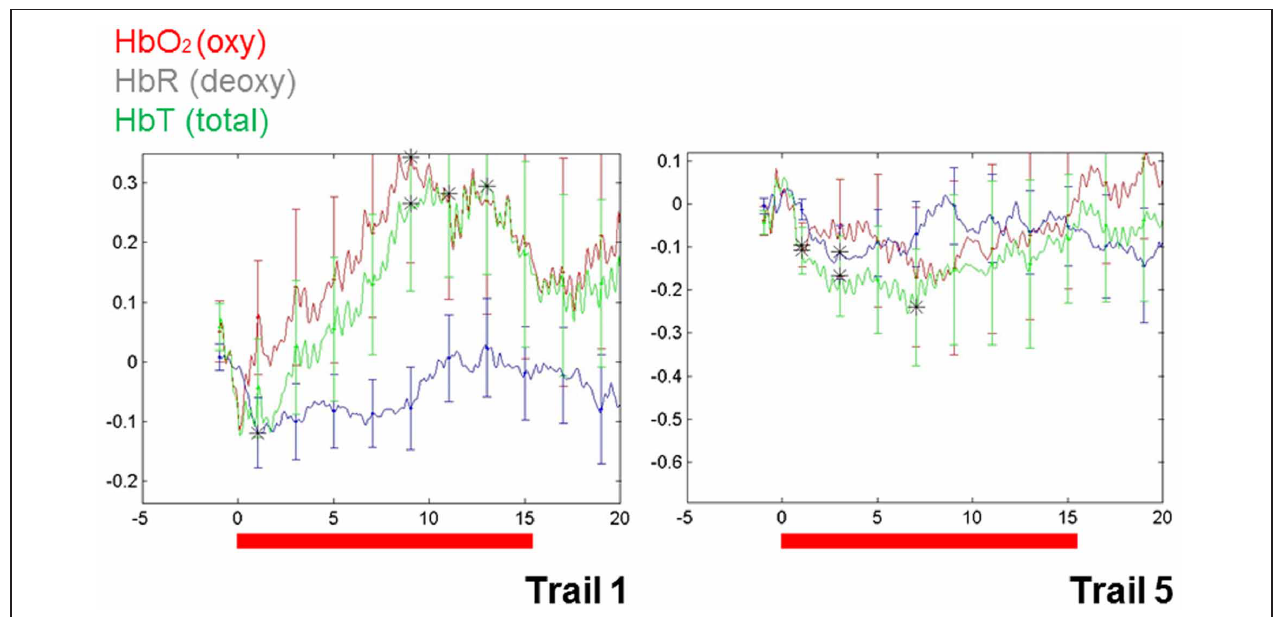
FIGURE 1 | Changes in blood flow in a single 9-month-old infant during the first and the final (fifth) series of repetitions of a single, monosyllabic word. The Y-axis is relative changes in concentration